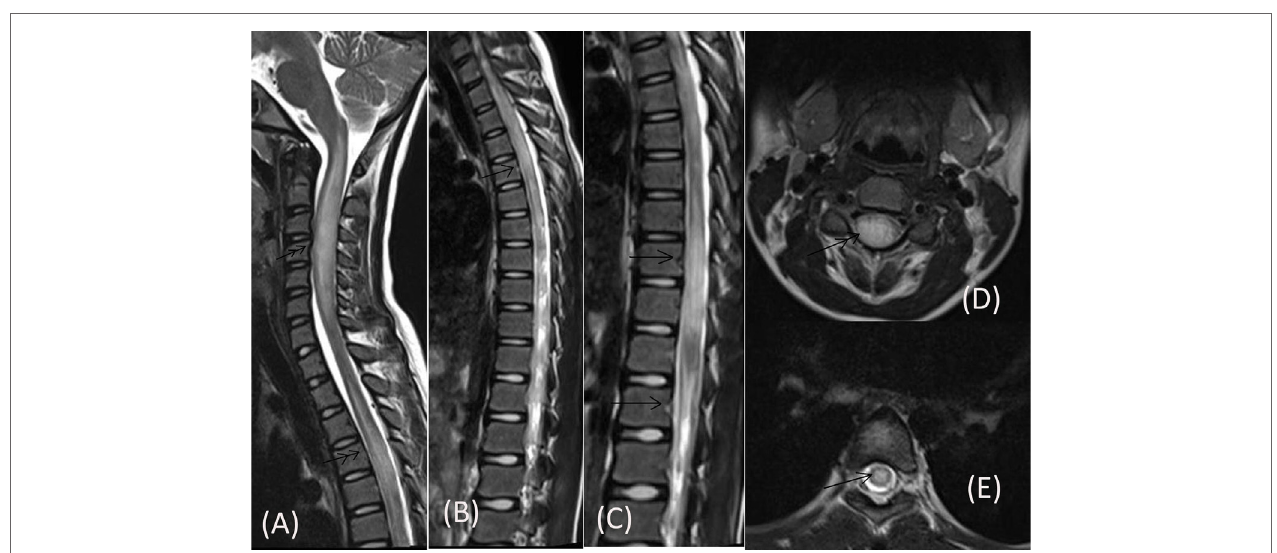
FIGURe 1 | MRI of cervical spine done prior to admission showing long segment centrally located lesions in form of t2 hyperintensity in cervical cord (double arrow) [saggital (a), axial (D)] and dorsal cord (single arrow) [saggital (B,C), axial (e)]